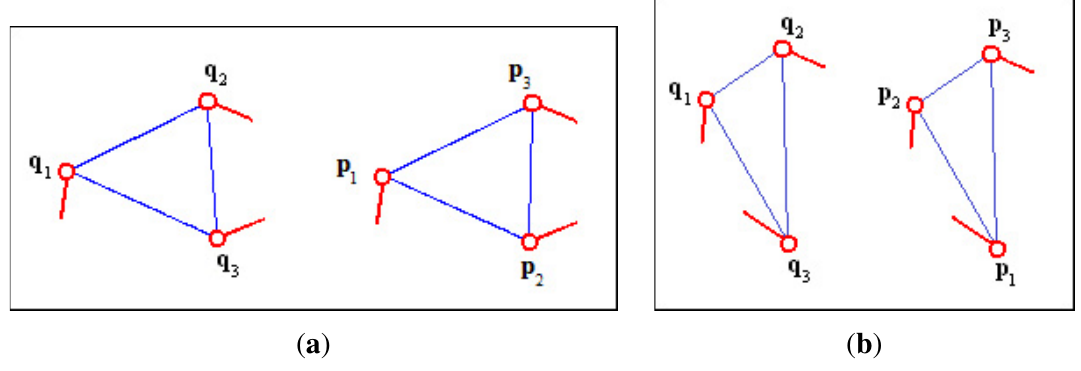
; p ; p ) is a reflected version of 1 2 3